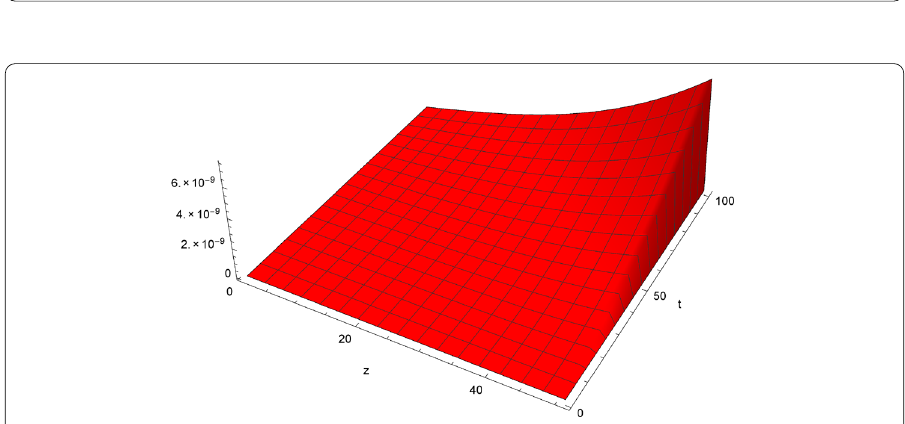
Figure 8 Exact and approximate solutions for Example 3, when N = 50, α = 1.6 and (cid:11) t = 0.01, t = 1